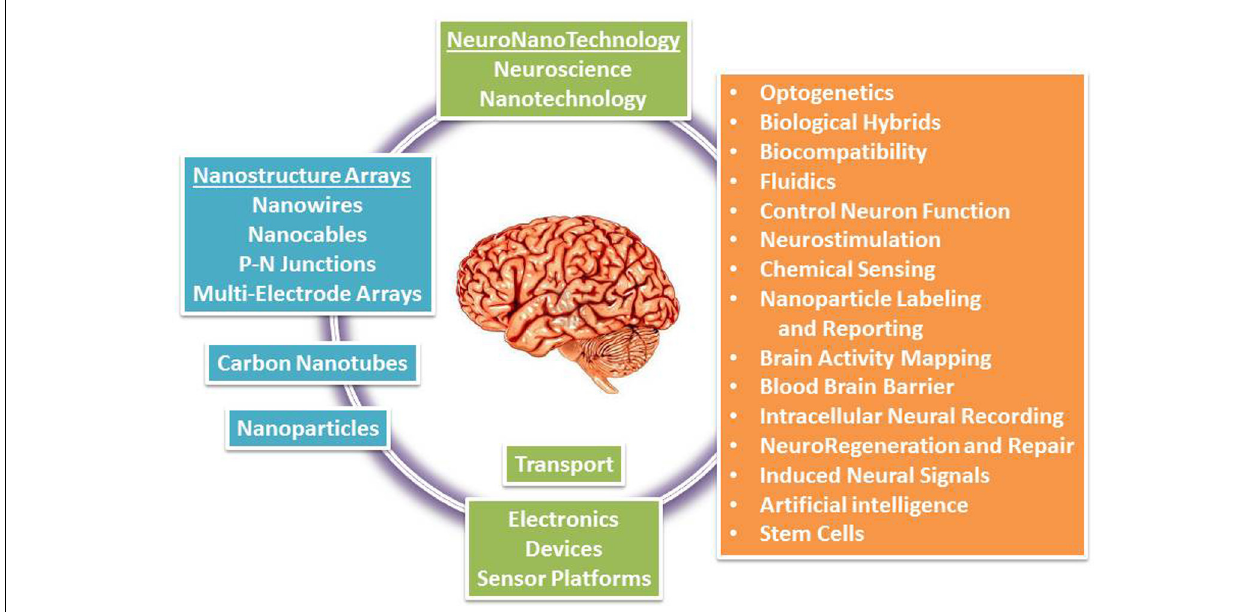
FIGURE 1 | Illustration of nanotechnology integration into the brain